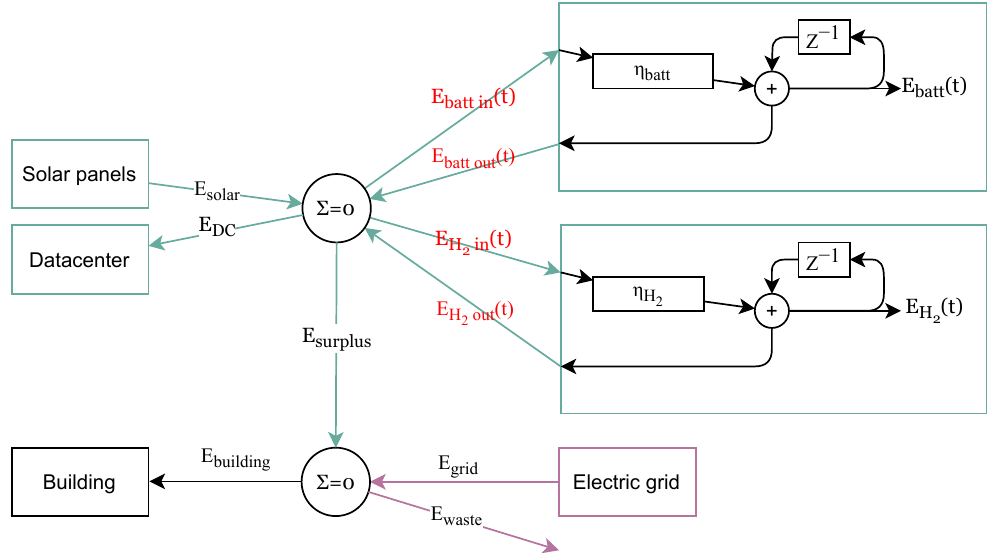
Figure 1. View of our system. lines in green shows the solar-only part and purple lines shows the grid-only part. actions are displayed in